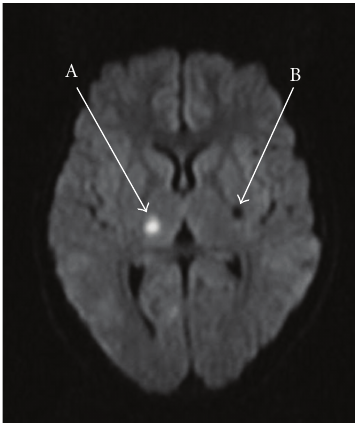
Figure 1: Di ff usion-weighted imaging (DWI) MRI of the brain showing an acute SVI involving the right thalamus (A) and an older SVI involving the left internal capsule (B).